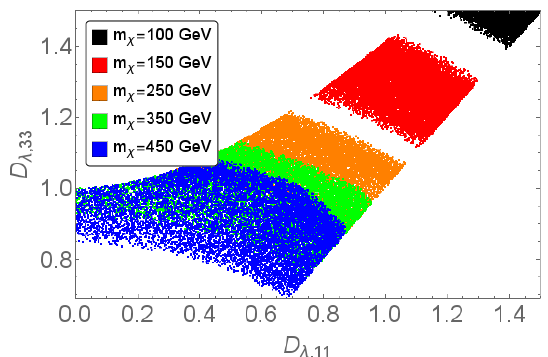
Figure 5 . Viable regions of parameter space of the quark-doublet DMFV model in the QDF scenario (with m (cid:30) = 850 GeV and (cid:17) = (cid:0) 0 : 01) compatible with the relic abundance constraint, at di(cid:11)erent DM